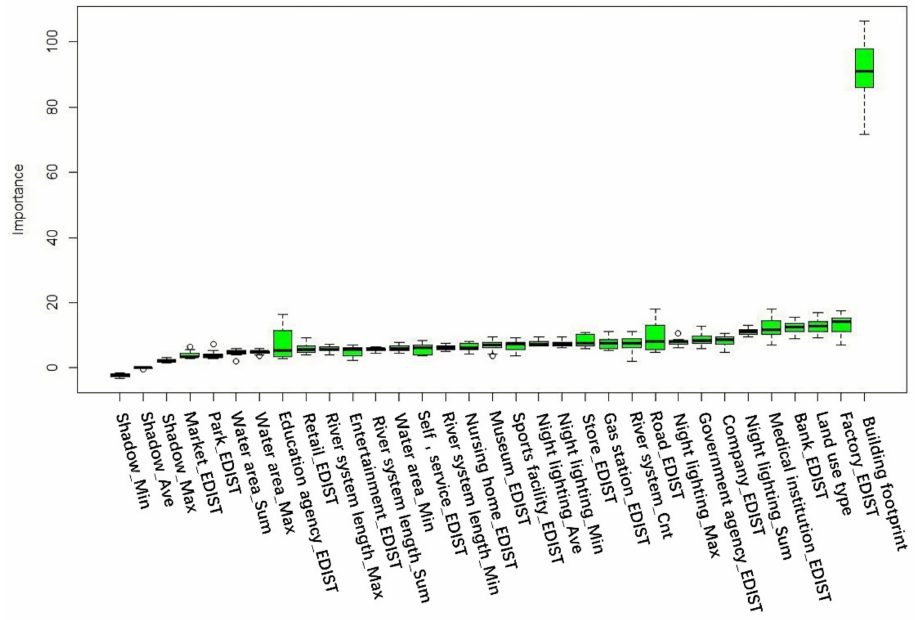
Figure 13. Evaluation of feature